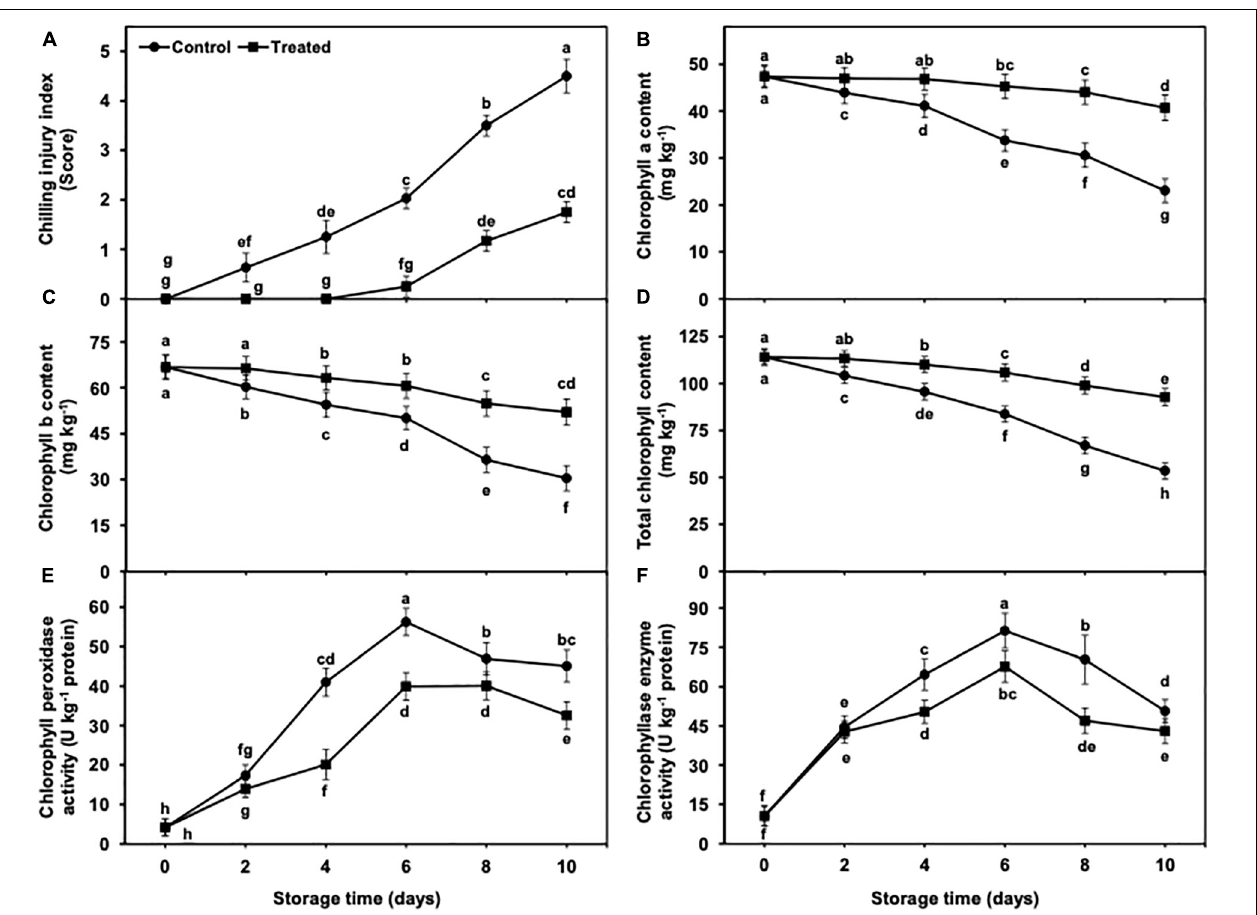
FIGURE 1 | Effect of hydrogen sulfide on chilling injury index (A) , chlorophyll a content (B) , chlorophyll b content (C) , total chlorophyll content (D) , chlorophyll peroxidase (E) and chlorophyllase (F) enzyme activity in peel of banana fruit. Data are mean of three replications and vertical bars show standard of the means. Different letters show significant difference according to least significant difference